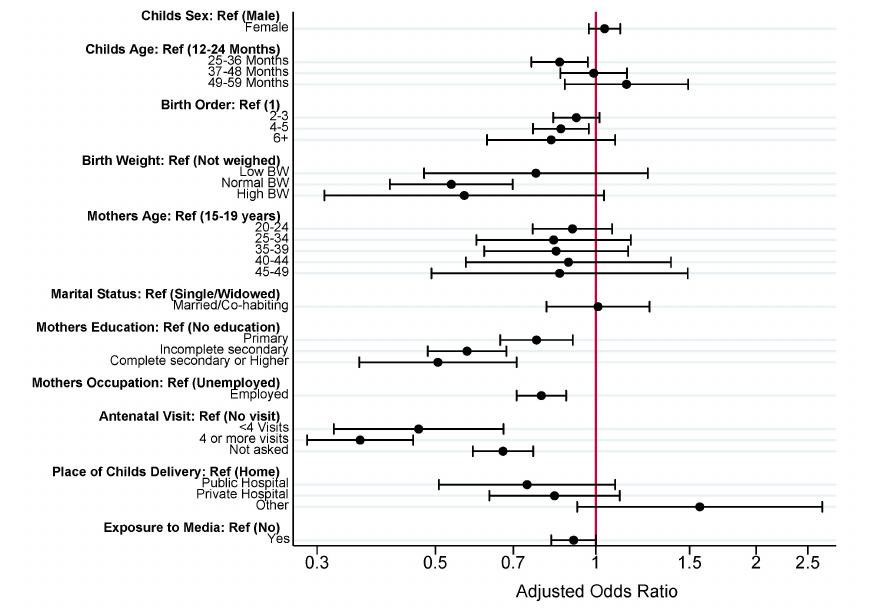
Figure 1. Multi-level analysis of individual factors associated with zero-dose vaccination status among children aged 12–59 months in SSA. Estimates from Model 4 (Table S1). X-axis presented on natural log